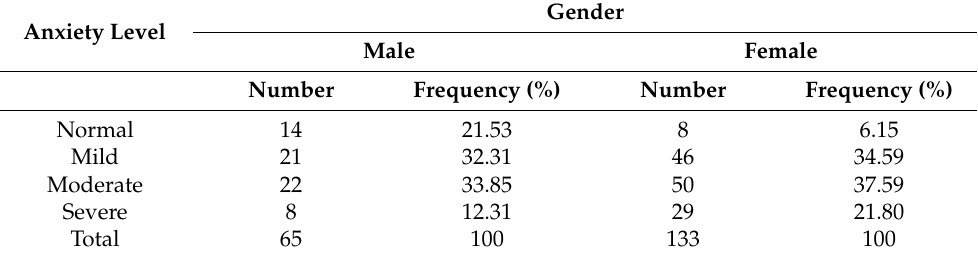
Table 3. GAD-7 and gender ( n = 198).